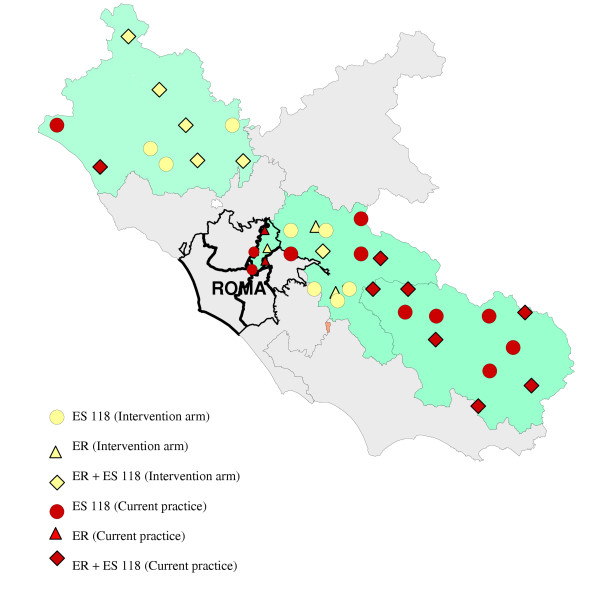
Territorial distribution of the entities enclosed in the study.